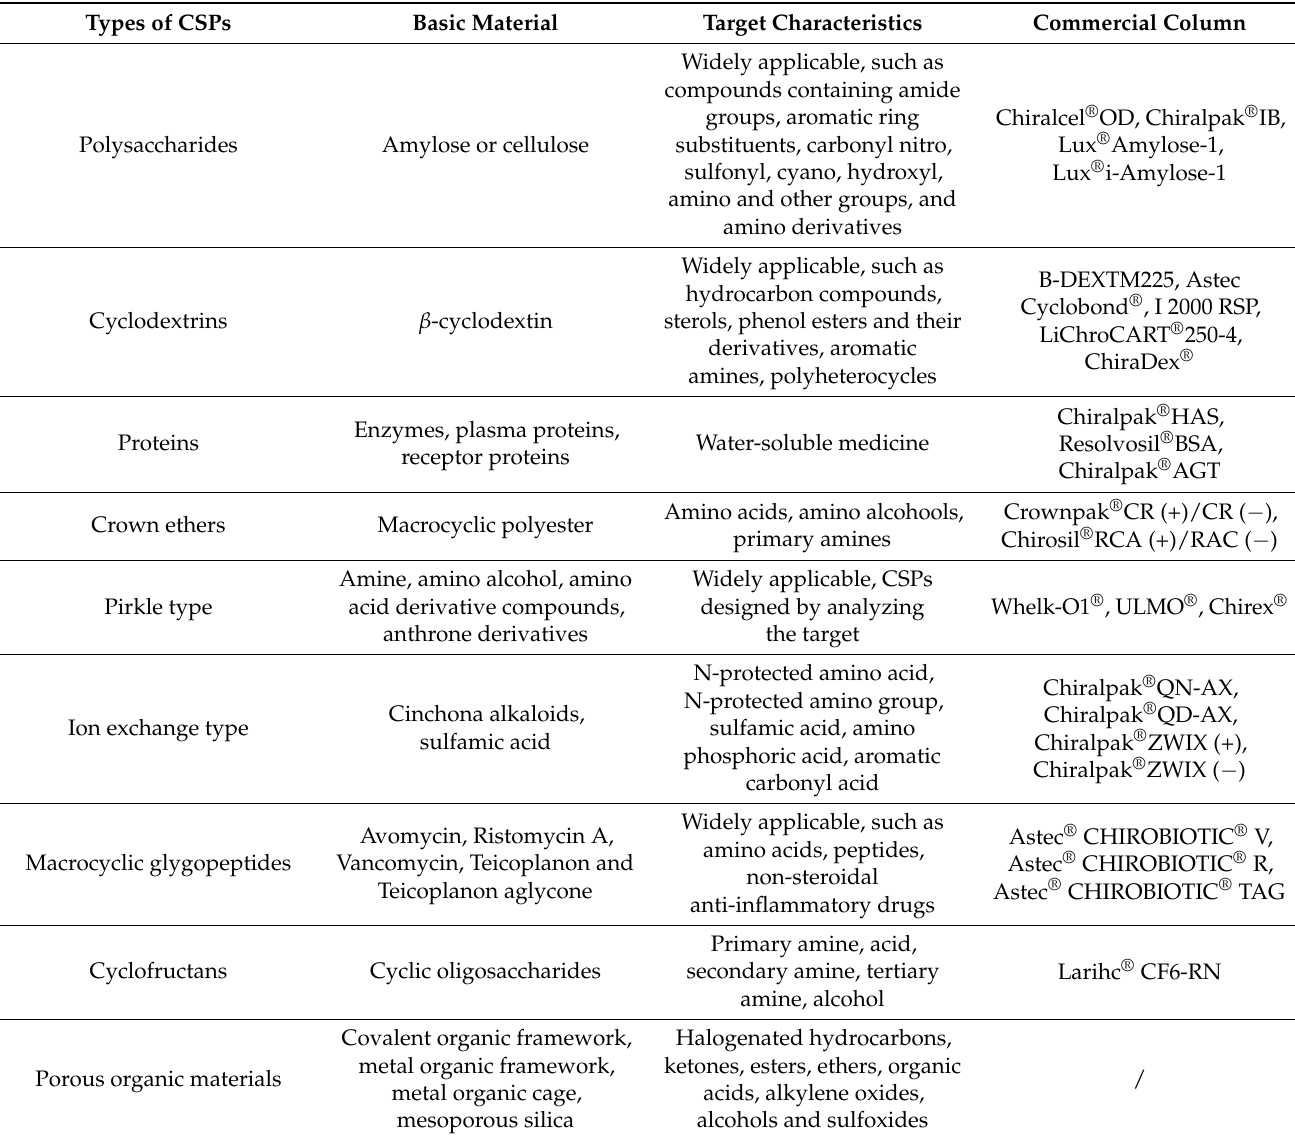
Table 3. Target characteristics and commercial columns corresponding to chiral stationary phases (CSPs). Reproduced with permission from the authors of